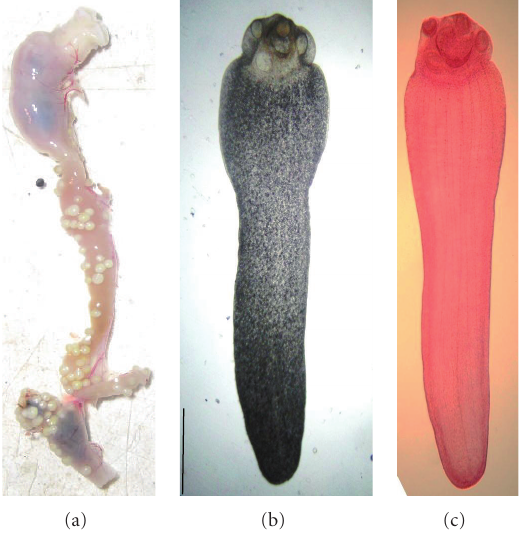
Figure 4: (a) Cysts of cestodes attached to the small intestine, large intestine/rectum of Ptychadena bibroni from Agbede; (b) and (c), mechanically excysted proteocephalid cestode larva (unstained and stained, resp.). Scale bar: 0.5 mm.